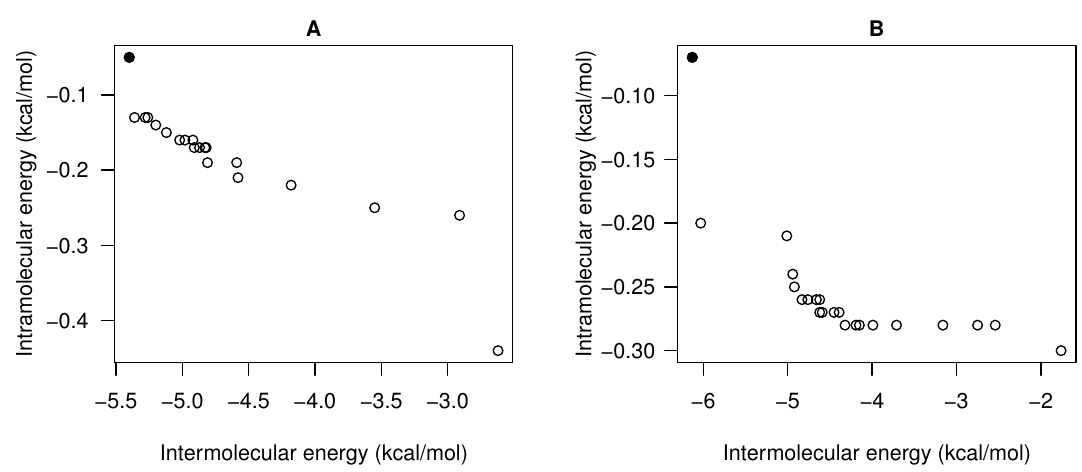
Figure 8. ( A , B ) show the SMPSO fronts of non-dominated solutions of Runs 7 and 23 (out of 30) for the aeroplysinin-1 docking instance. The black points are the solutions selected from the set of solutions of each run. The final binding energy of the black point at left side of the front corresponds to − 4.21 kcal/mol. The E − 5.4 and − 0.05 kcal/mol, respectively. The final binding energy of the black point of the right boxplot corresponds to − 4.93 kcal/mol. The E − 0.07 kcal/mol,